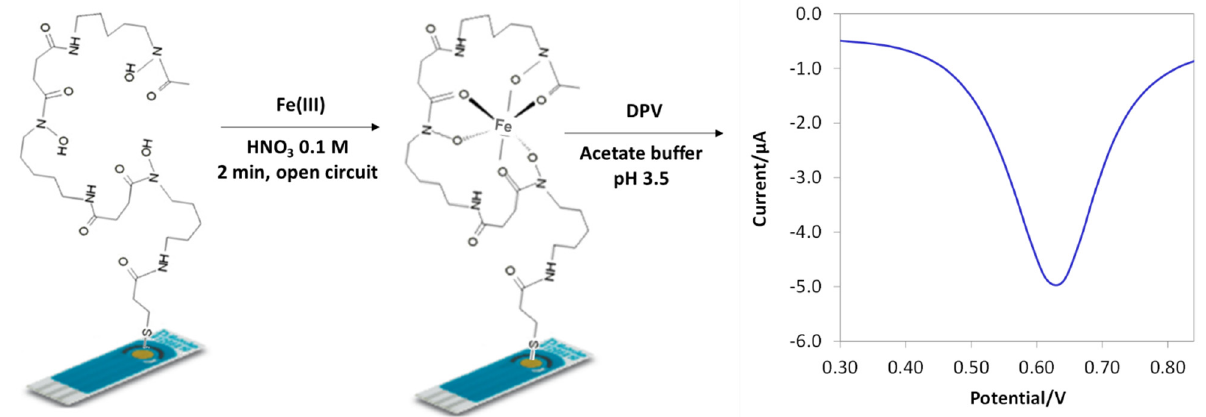
Figure 3. Schematic representation of Fe(III) determination procedure by Scheme 1. min), the quantity of iron(III) reaching the electrode surface is small, and only after immersion in solutions at high Fe(III) content, a signal significantly different to that of the background appeared. Other- wise, if selecting a longer accumulation time (higher than 5 min), a saturation of the DFO sites of